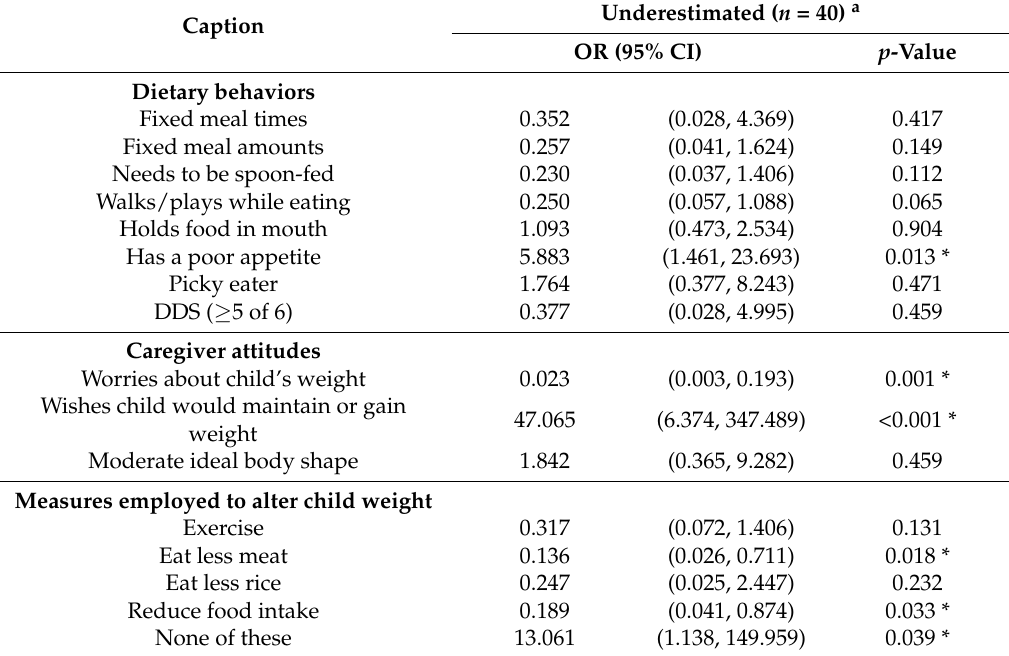
Table 5. Associations between caregiver perceptions of child weight and dietary habits for overweight/obese